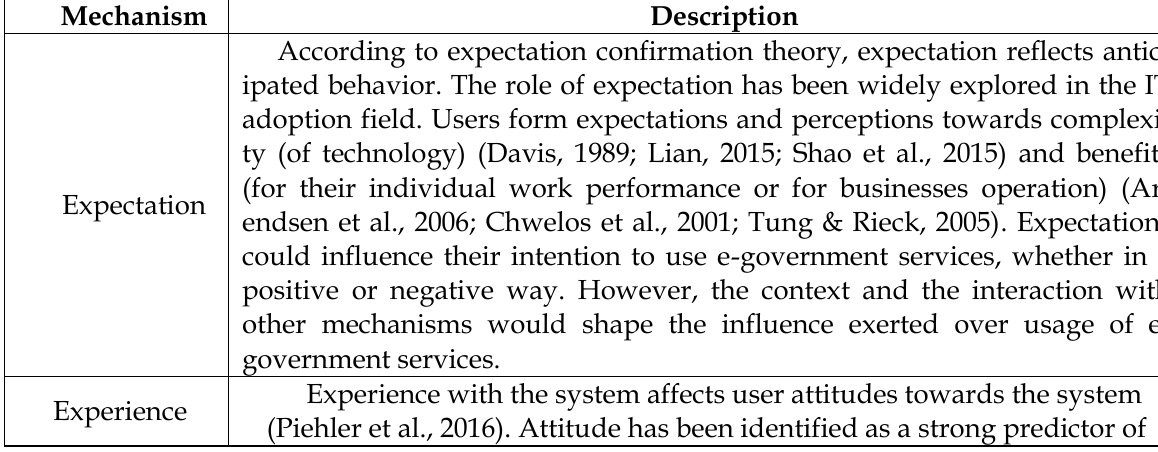
Table 12. Mechanism's description